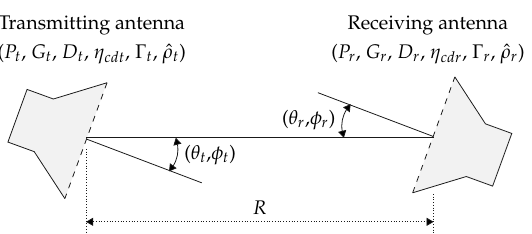
Figure 20. Orientation and parameters of the transmit and receive antennas, based on